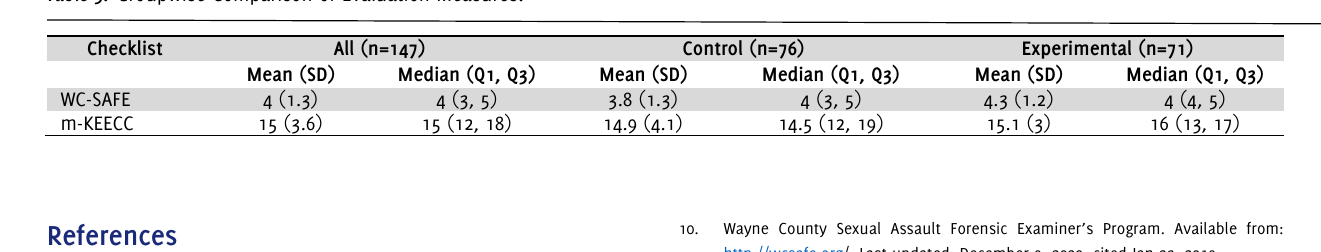
Table 3 . Groupwise Comparison of Evaluation Measures